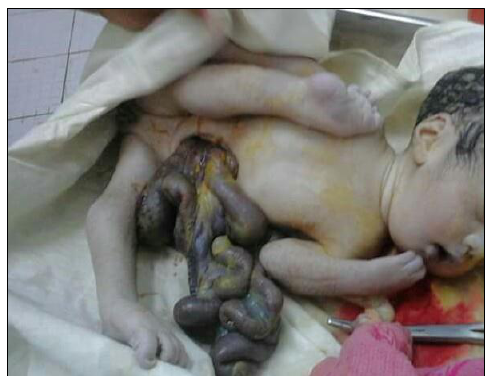
Figure 1. Photograph of newborn showing herniation of small and large intestine through a right paraumbilical wall defect with associated deformed limbs (Case